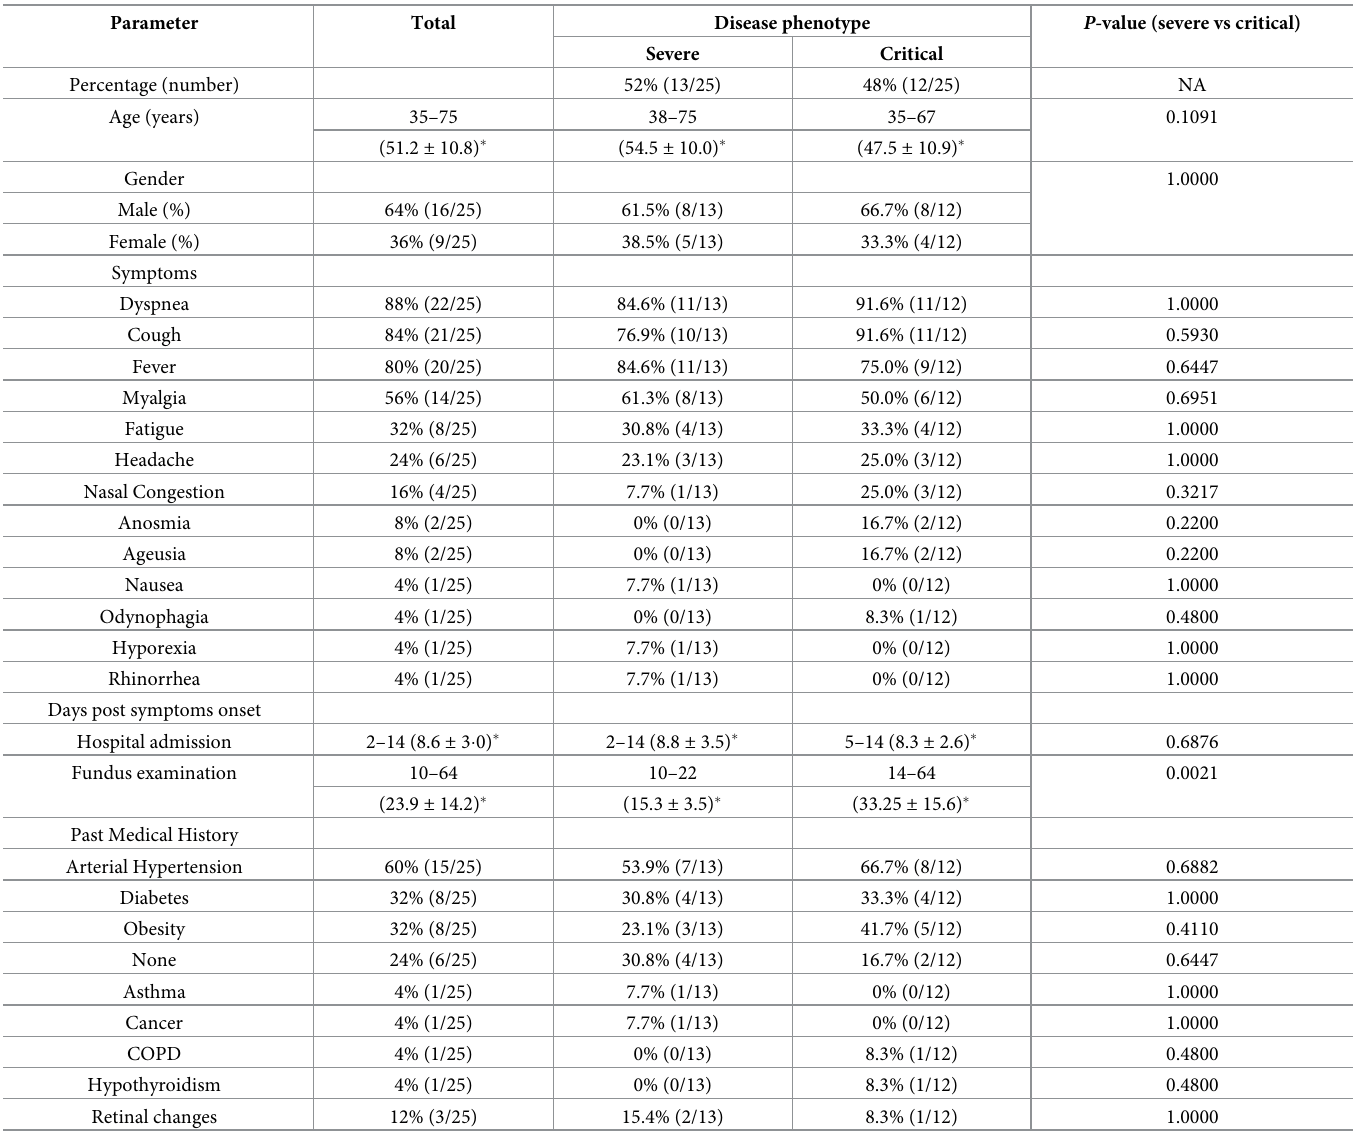
Table 1. General and demographic characteristics from enrolled